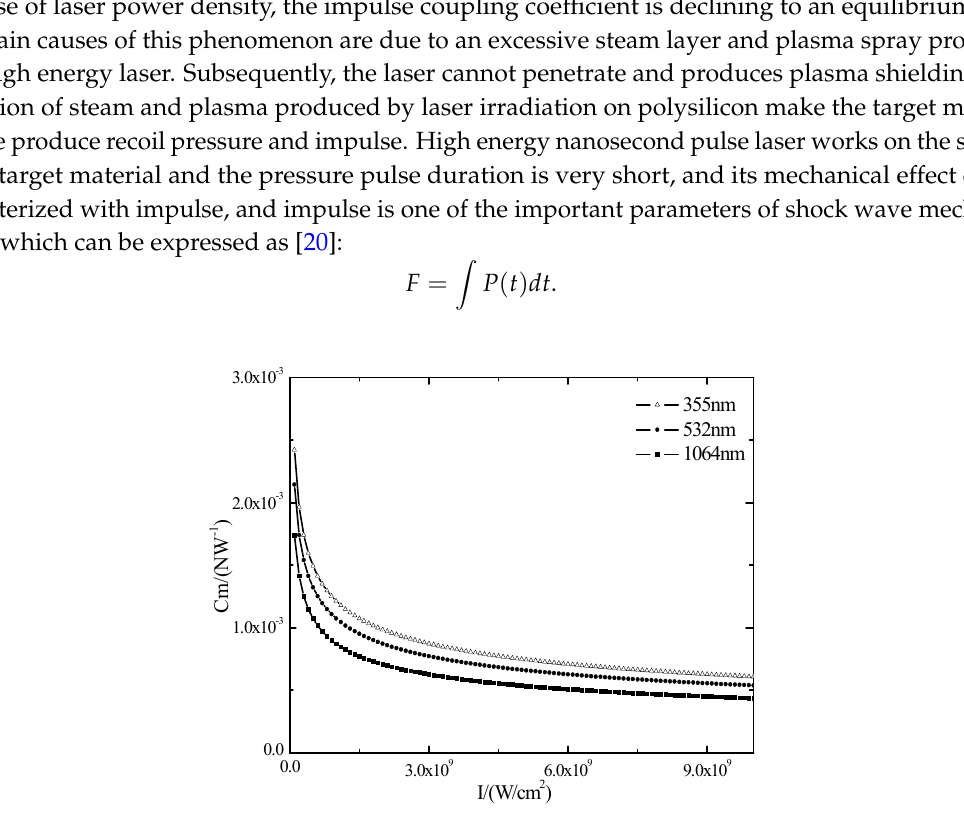
Figure 8. The relationship between laser parameters and coupling coefficient of the polysilicon.